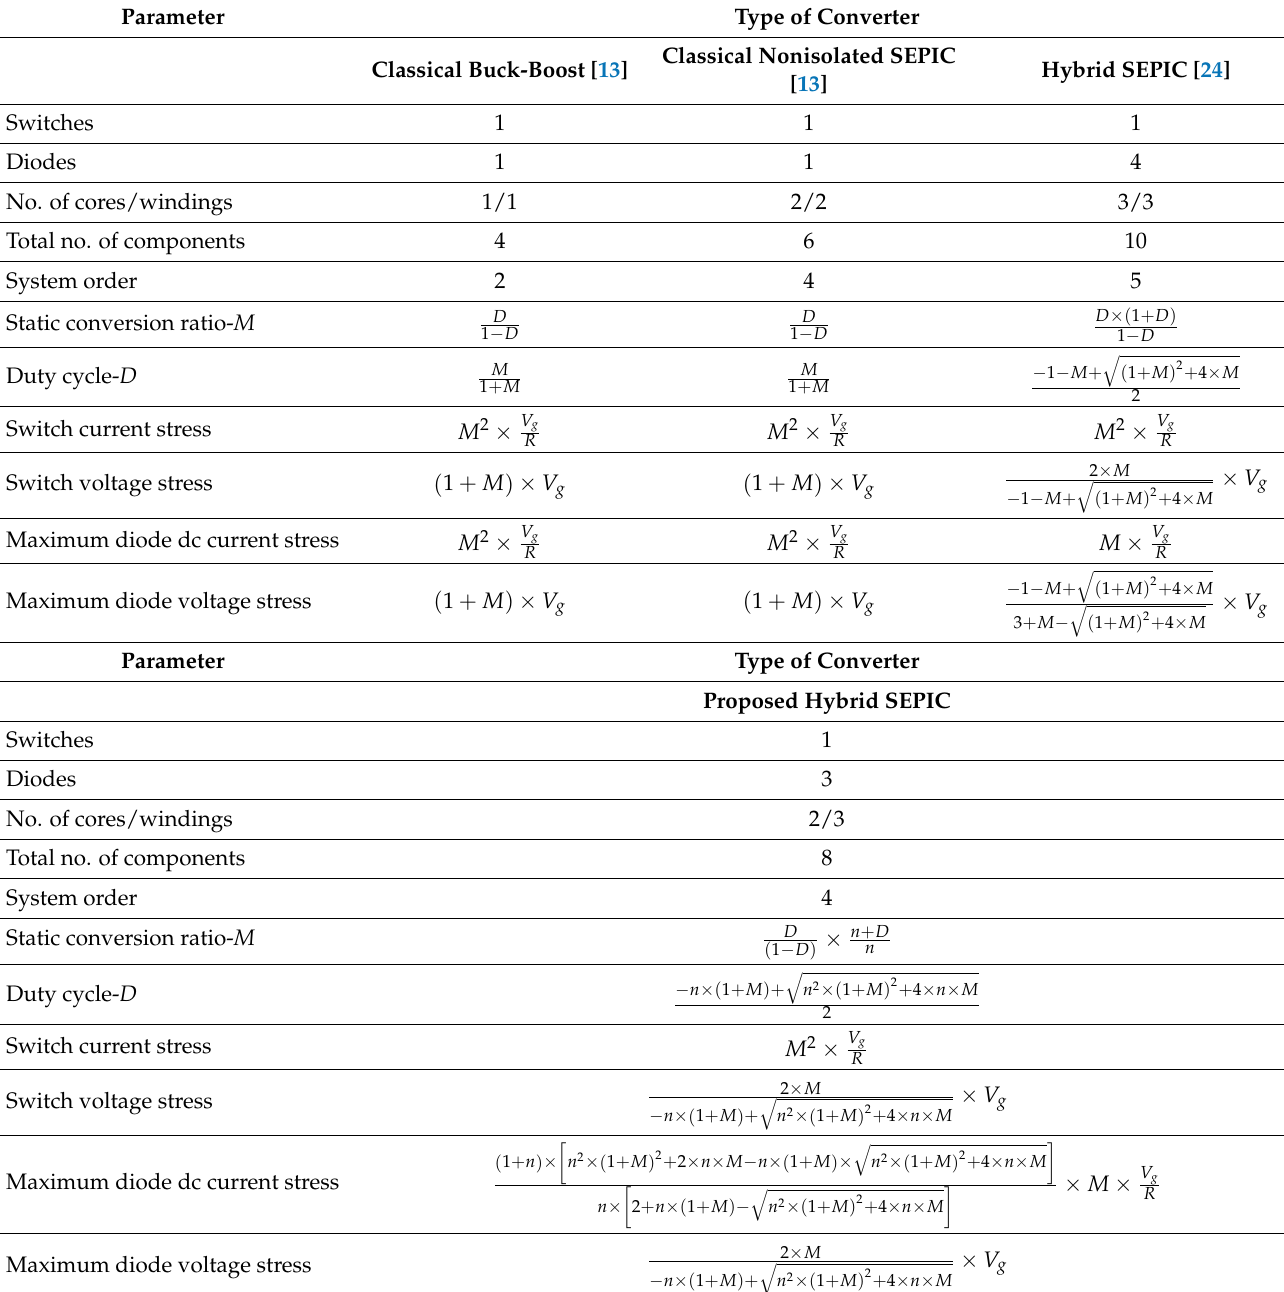
Table 1. Comparison between the main parameters of different step-down/step-up